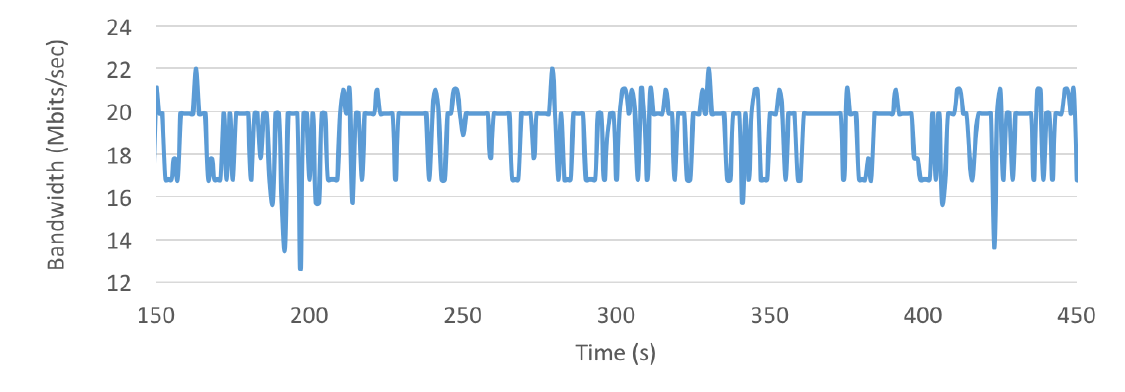
Figure 23. Bandwidth fluctuation when transmitting from an emulated tag to the